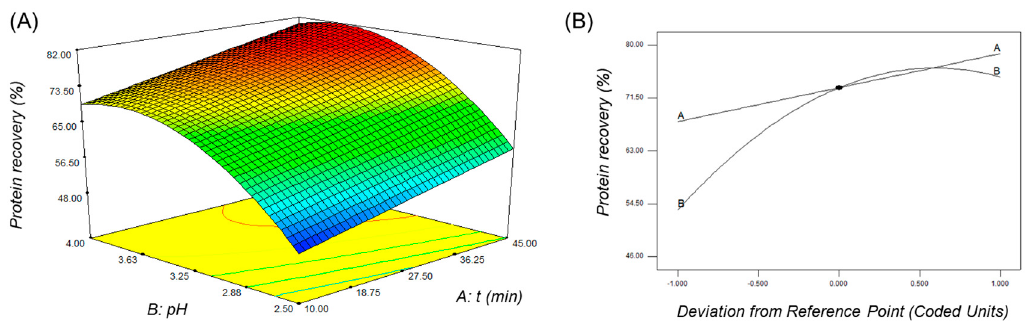
Figure 4. ( A ) 3D contour plot of percentage total protein recovery from A. platensis and ( B ) Perturbation plot of percentage protein recovery—M2.